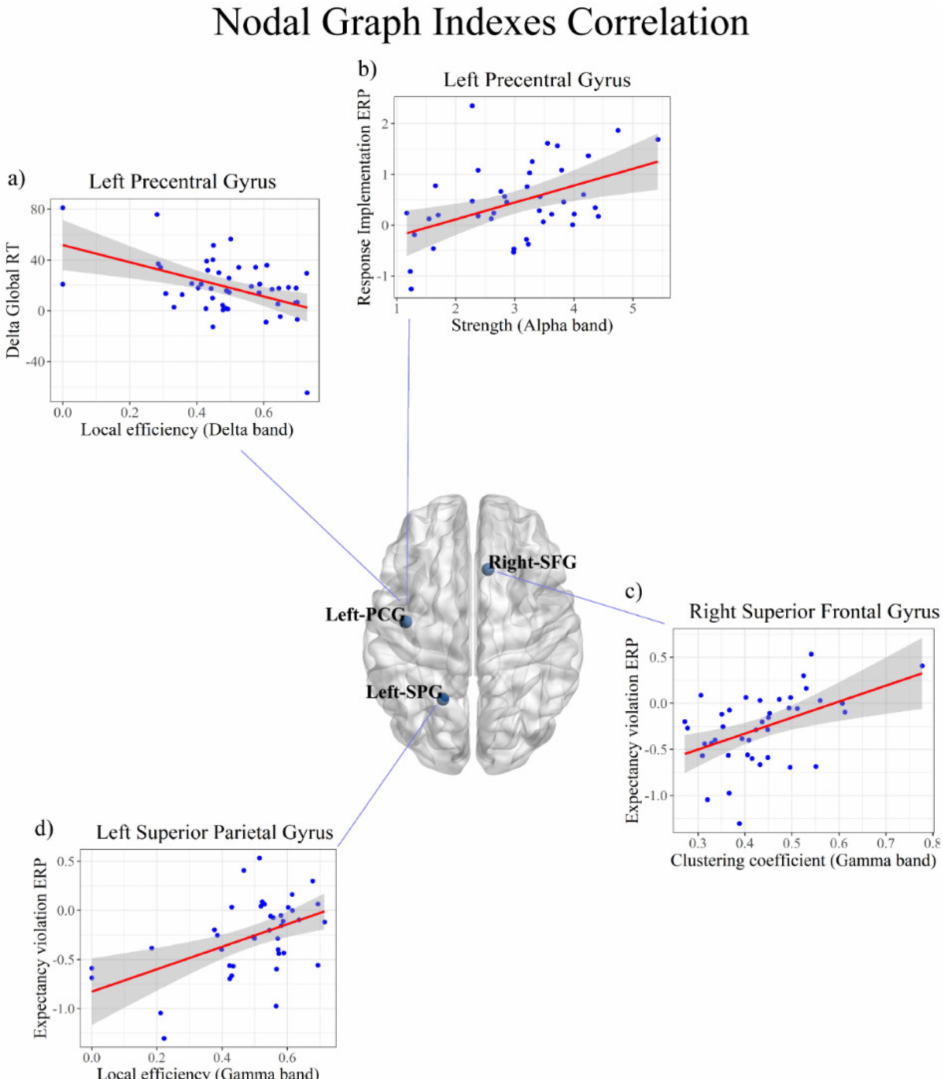
Figure 7. Correlation between the nodal graph indexes and task-dependent behavioral and ERP effects. The pictures represent the significant correlations between the nodal graph indexes and behavioral or ERP effects. The shaded area around the regression line represents the 95% confidence interval. ( a ) correlation of the local efficiency in the delta band of the left Precentral Gyrus (left-PCG) with the behavioral performance (delta global RT). In ( b ) it is showed the correlation of the left-PCG nodal strength in the alpha band and the amplitude of the task-dependent P3 modulation (expectancy implementation). ( c ) correlation between clustering coefficient of the right Superior Frontal Gyrus in the gamma band and the omission detection potential (ODP) increase (expectancy violation). ( d ) correlation in the gamma band between left Superior Parietal Gyrus and task-dependent expectancy violation